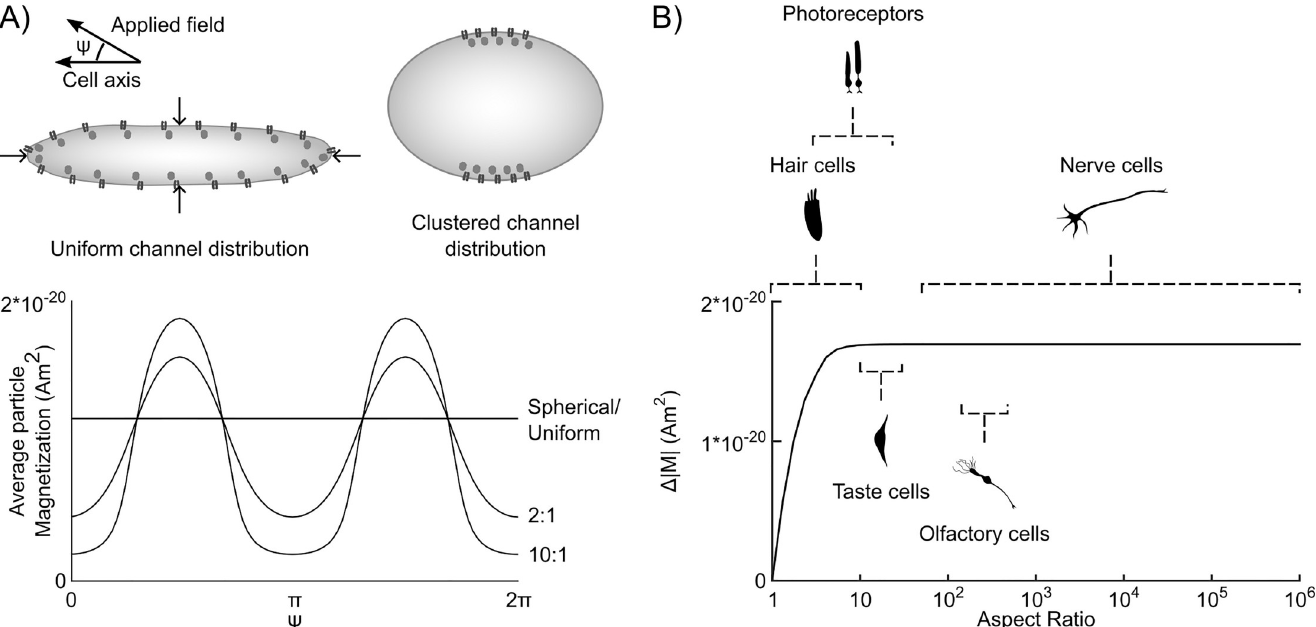
Fig 2. Arrangements of RME-receptors that could produce cells that respond to specific field directions. (A) Two potential arrangements of RME-receptors that would produce a change in average particle magnetization under cell rotation: a high cell aspect ratio with uniformly (or randomly) distributed RME-receptor channels, or a cell of any shape in which the RME-receptor channels cluster together. Either configuration will result in larger numbers of channels oriented along specific axes (along angles c ¼ p in this example), and fewer along others (angles ψ = 0, π in this example). As a result, the average particle magnetization changes 2 when the cell rotates, which generates or absorbs heat (assuming the easy axis is consistently aligned with the channel pore). Plot shows average magnetization of particles in RME-receptors for prolate spheroidal cells rotating in an Earth-strength magnetic field (with aspect ratios of 1, 2, and 10). Cells with larger aspect ratios will produce greater changes in average particle magnetization under rotation. (B) The maximal change in average channel magnetization is shown as a function of cell aspect ratio for randomly distributed channels with orientation-locked particles. The change in average particle magnetization (which corresponds to the average heat generated or absorbed per particle) increases asymptotically with cell aspect ratio. Cells with aspect ratios greater than * 20 are expected to show near-maximal average magnetocaloric heat generation. Many sensory cells show aspect ratios near or above this number, and thus could be candidate RME-receptive cells. Calculations of magnetization are based on 10 nm radius magnetite particles.